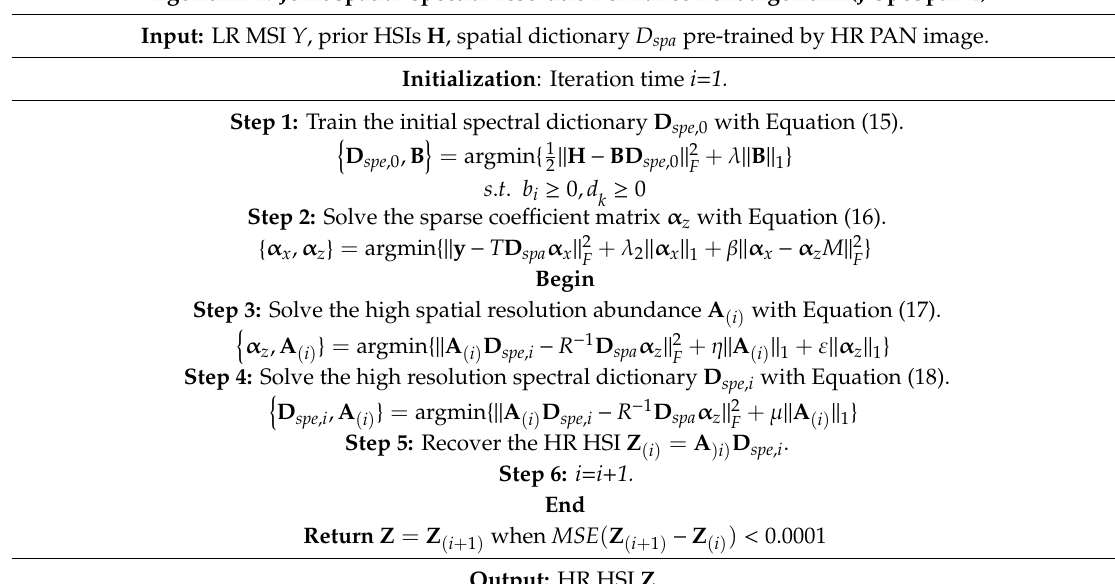
Algorithm 1: Joint spatial-spectral resolution enhancement